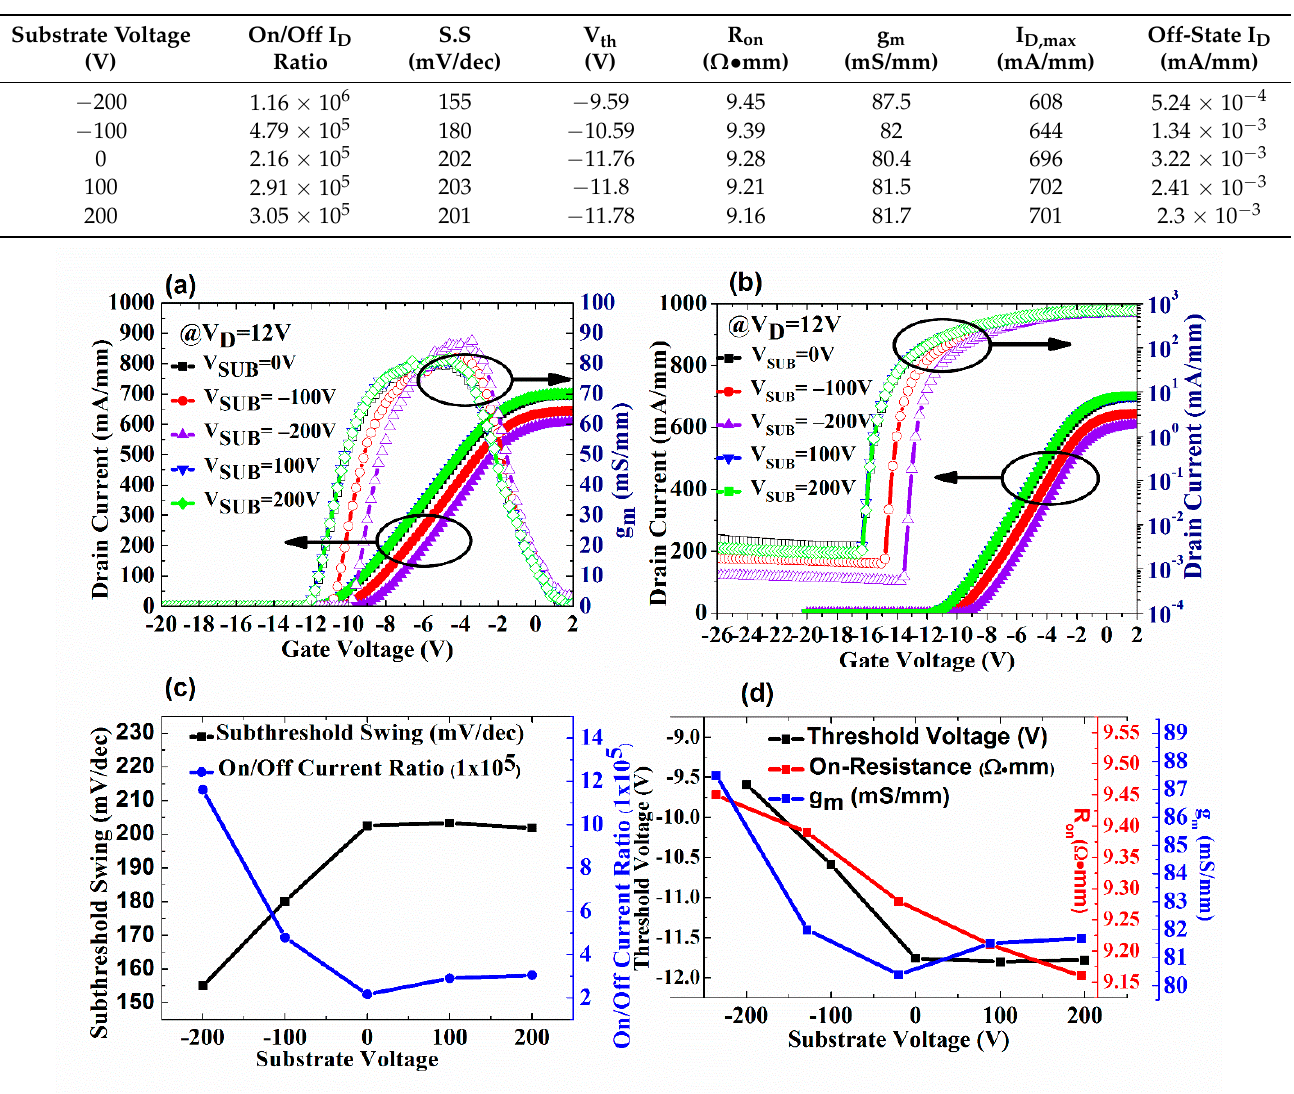
Figure 4. ( a , b ) I D -V G characteristics of the superlattice-based HEMT for different V SUB . ( c ) Comparisons of drain current (I D ), on/off ratio, and subthreshold swing versus (S.S) different V SUB . ( d ) Comparison of V th , R on , and g m versus different V SUB . Table 1. DC characteristics of the GaN-on-Si HEMT with different substrate voltages.